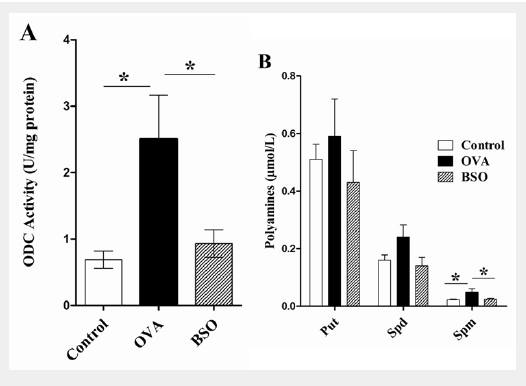
Black seed oil decreased the ODC activity and polyamine production. A, represents the activity of ODC in the lung homogenate of experimental rats. Polyamines such as putrescine (Put), spermidine (Spd) and spermine (Spm) isolated from lung of experimental rats (B). The dansyl derivatives of polyamines were determined by HPLC method. Data shown as mean ± S.E.M for 10 rats each group. * P <0.05 compared between two groups.